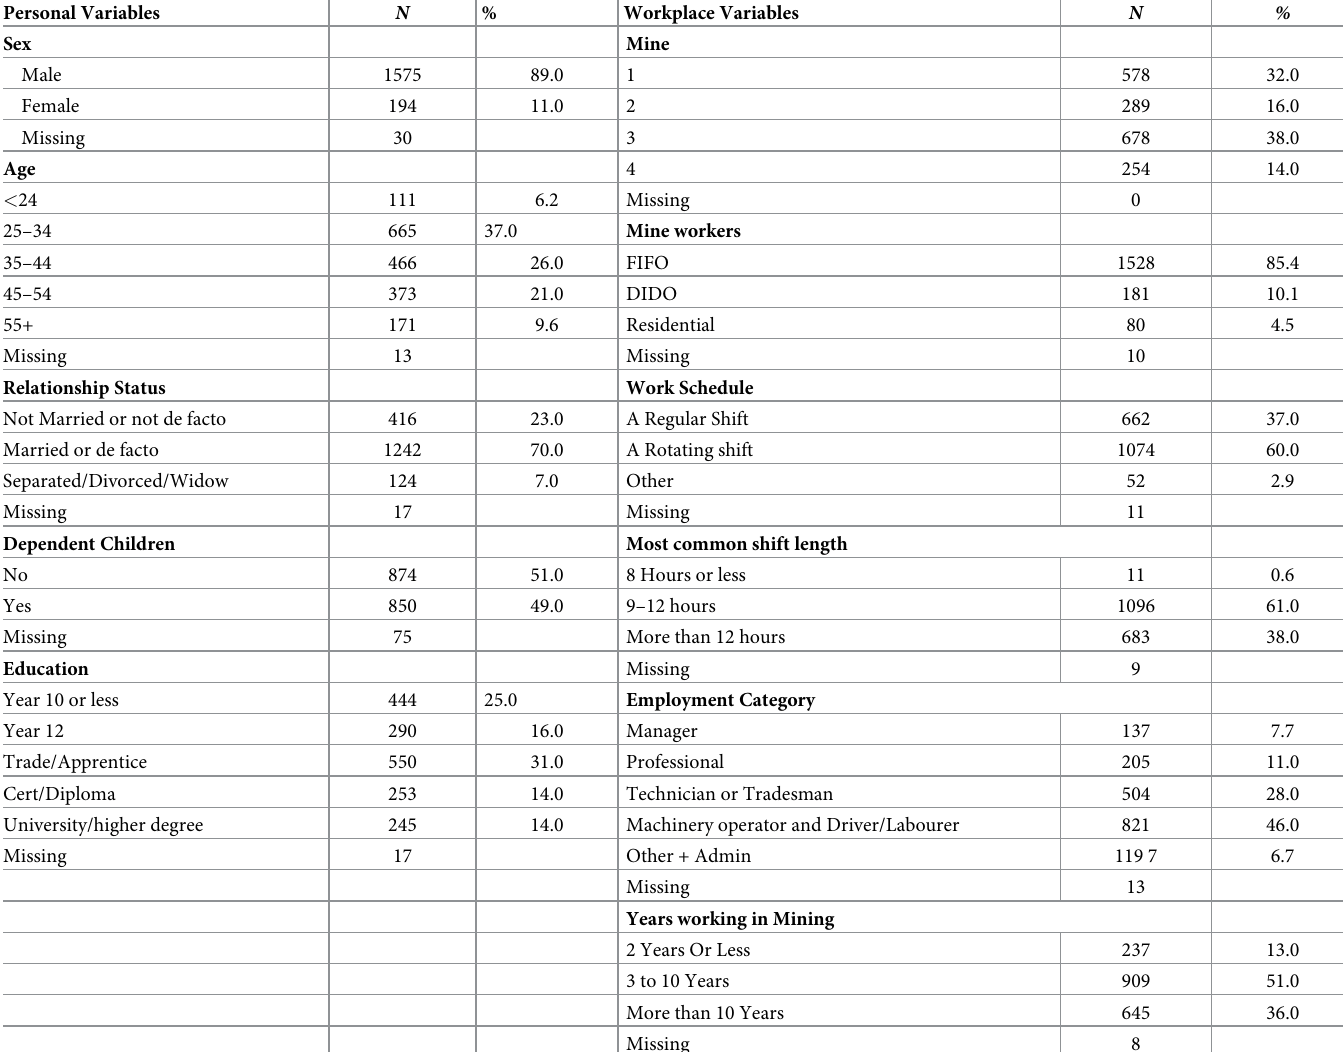
Table 2. Distribution of demographics and workplace characteristics of the sample (n =